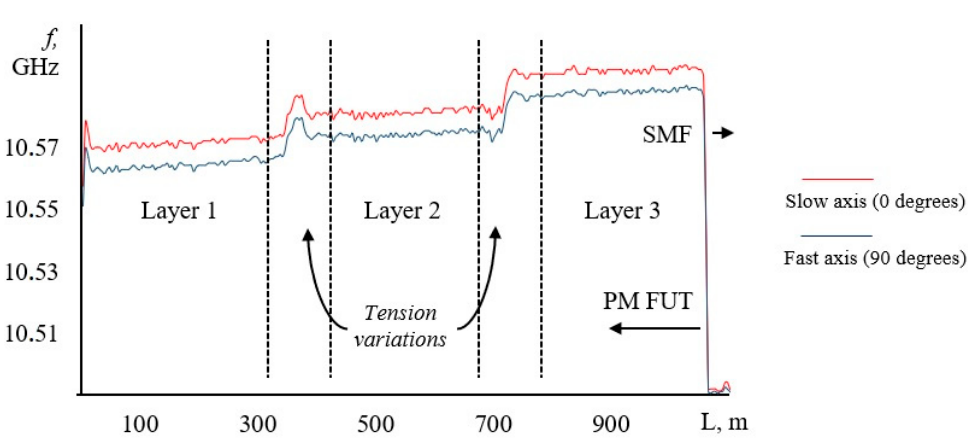
Figure 7. BOTDA-traces for slow and fast axes of the studied fiber ( f , GHz versus length, m).